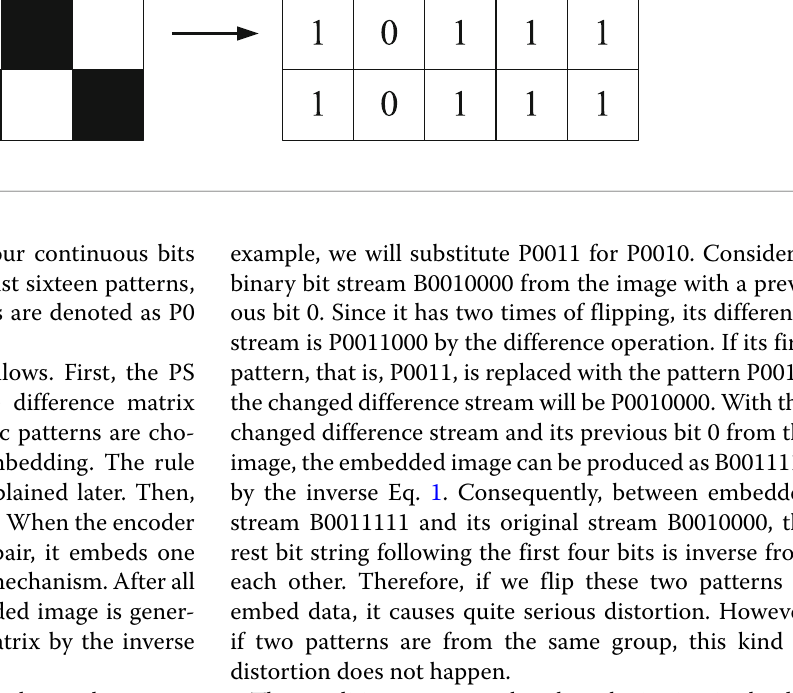
Fig. 1 A binary image and its difference matrix